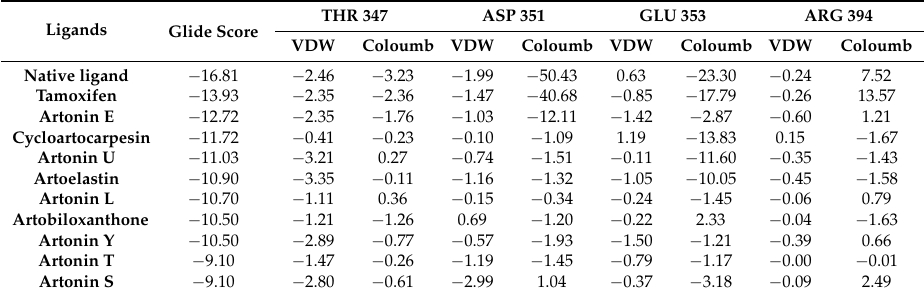
Table 2. Glide scores of studied ligands with their electrostatic interactions (kcal/mol) with critical amino acid at the ligand-binding domain of hER α .